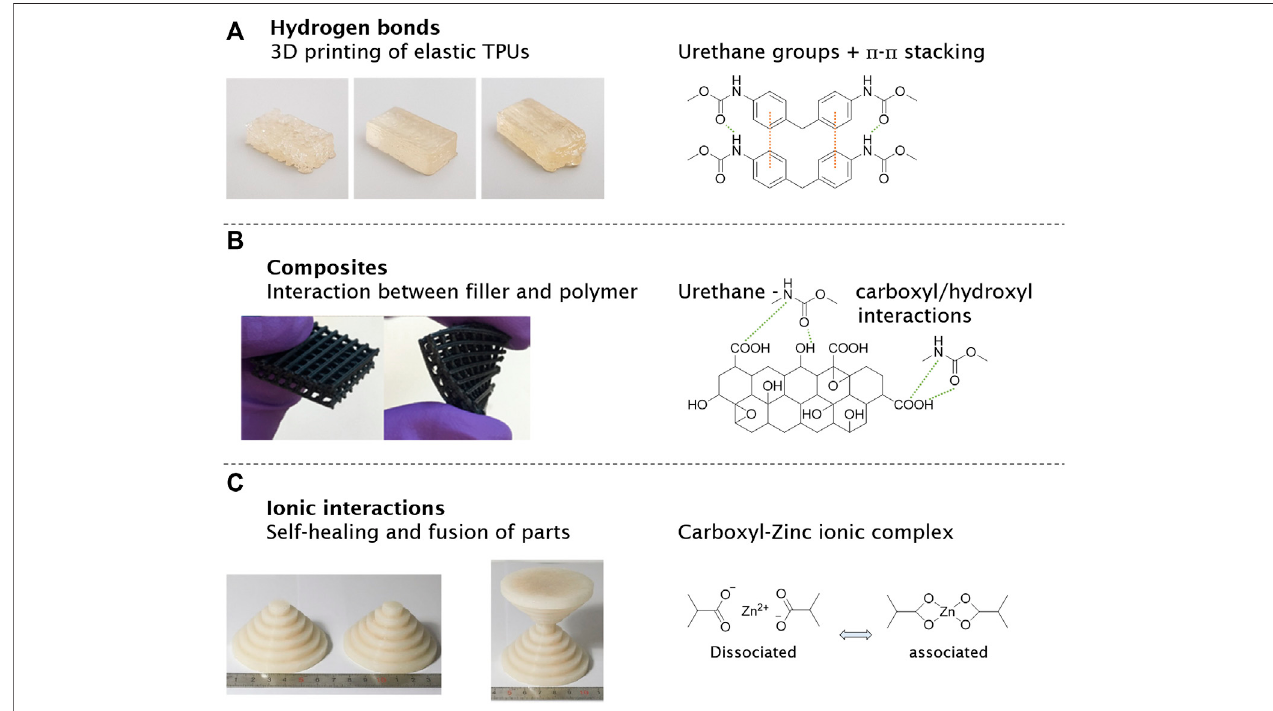
FIGURE 6 | 3D-printed supramolecular polymers and materials show new functionalities after manufacturing, reducing some limitations of extrusion printing. FDM printing of thermoplastic polyurethane (TPU) based on hydrogen bonds (urethane groups) and π - π stacking (A) . Composite materials with supramolecular interactions between polymer and graphene oxide were printed to elastic grids for tissue engineering (B) . An ionic-based supramolecular material was designed for its temperature- driven self-healing properties by carboxyl – zinc complexes (C) . Polymers reproduced with permission (Chen et al., 2017b; Lai et al., 2018; Ritzen et al.,